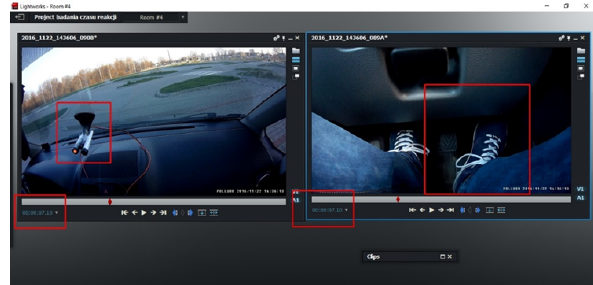
Figure 7: Example of a screenshot from a sample analysis program with the selection of relevant areas [18].